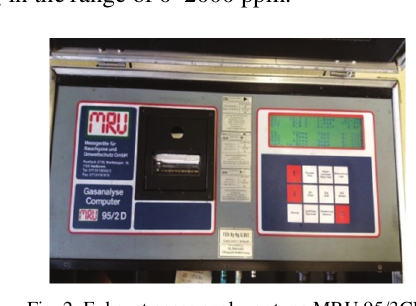
Fig. 2. Exhaust gases analyzer type MRU 95/3CD